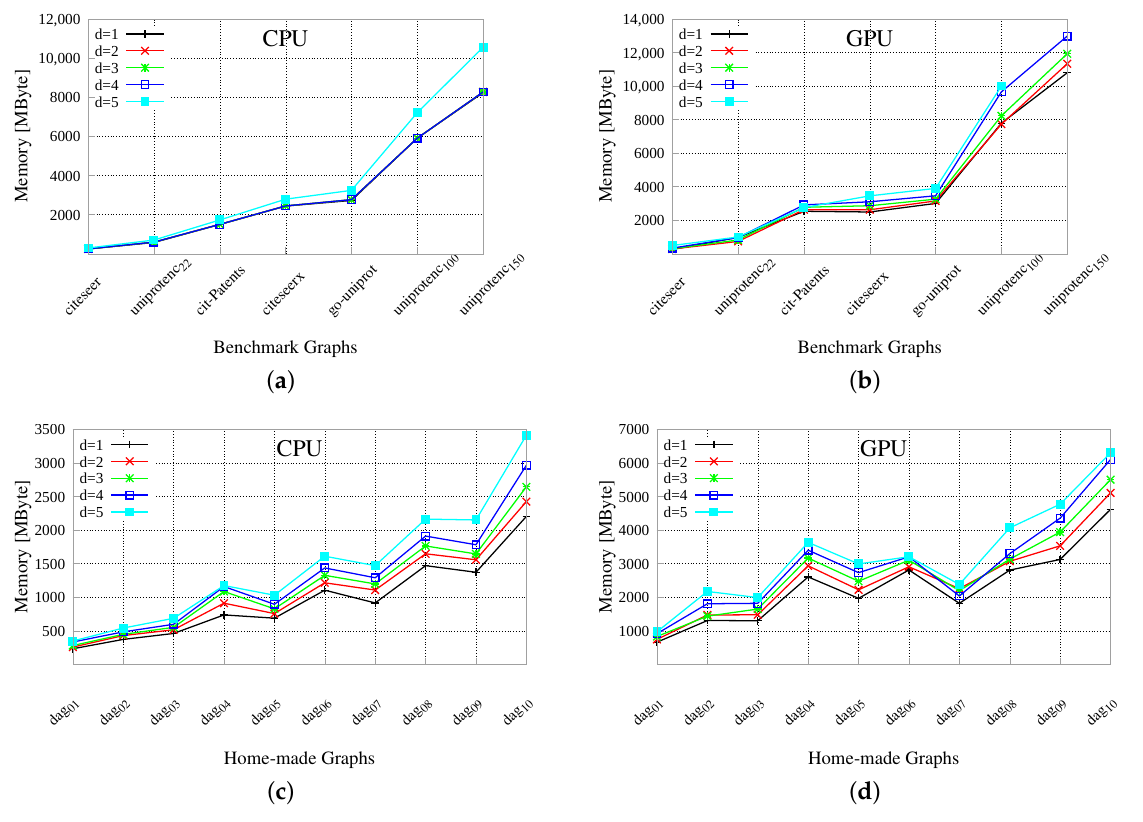
Figure 5. Memory results for benchmark and home-made graphs. The memory used is reported in MBytes, for different labeling size (from d = 1 to d = 5), Plots ( a , c ) reports the time for the original GRAIL implementation; plots ( b , d ) the ones for the GPU-based version. A value equal to 8192 MBytes (8 GBytes) corresponds to a memory